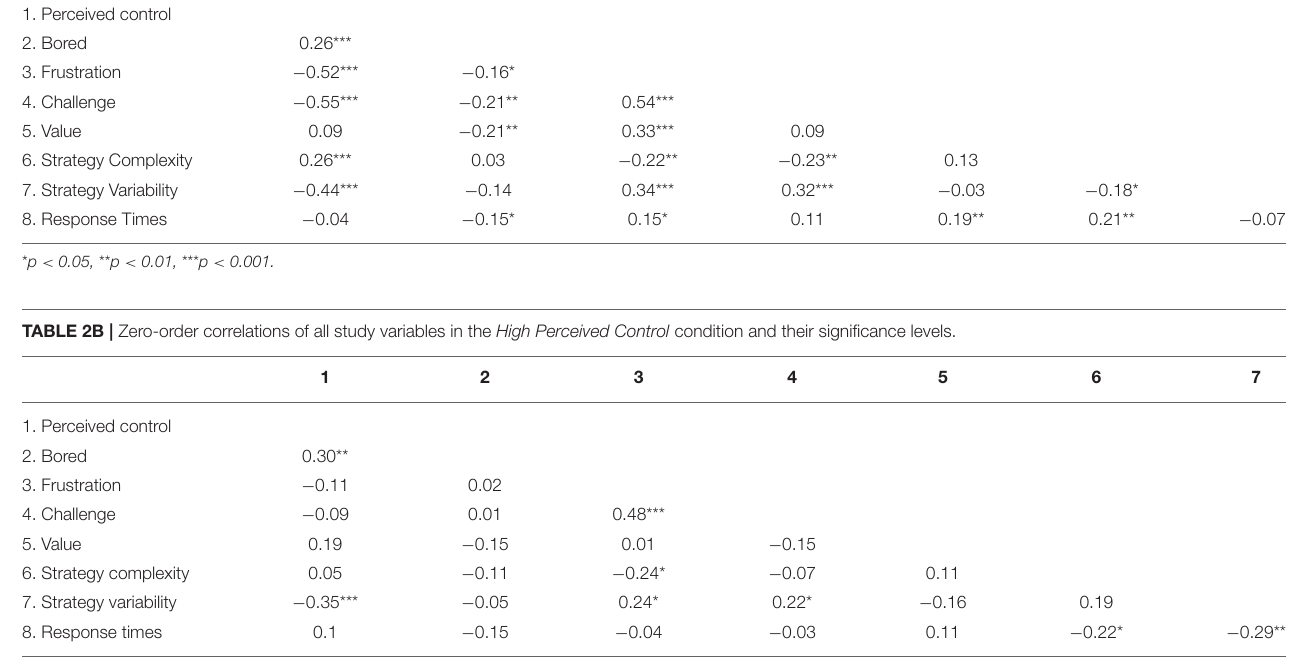
TABLE 2A | Zero-order correlations of all study variables and their significance levels (Study 1). 1 2 3